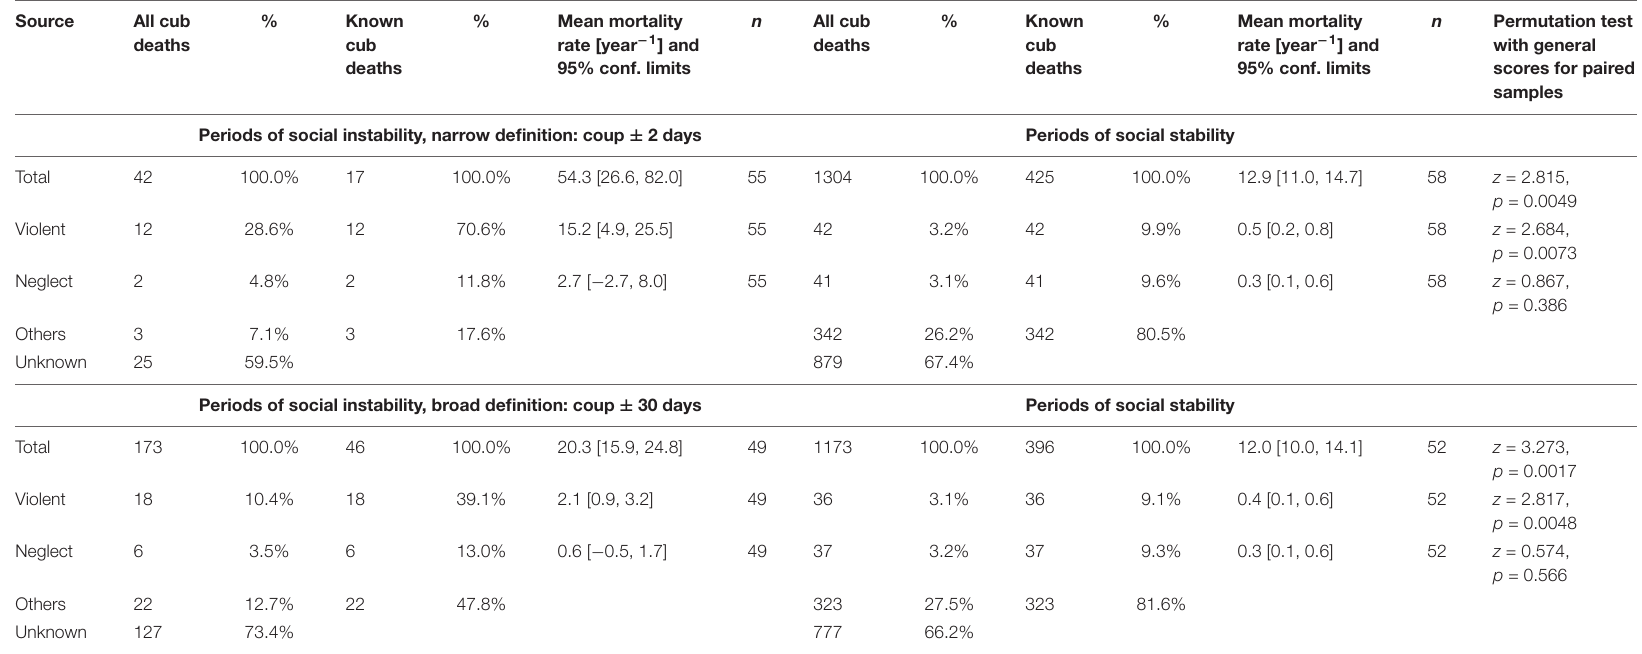
TABLE 1 | Number of deaths, incidences and rates of annual mortality for all spotted hyena offspring (Total) which died before reaching adulthood, as well as for those experiencing violent attacks (Violent) and infanticide by fatal maternal neglect (Neglect), during periods of social instability (coups) and stability in the three main study